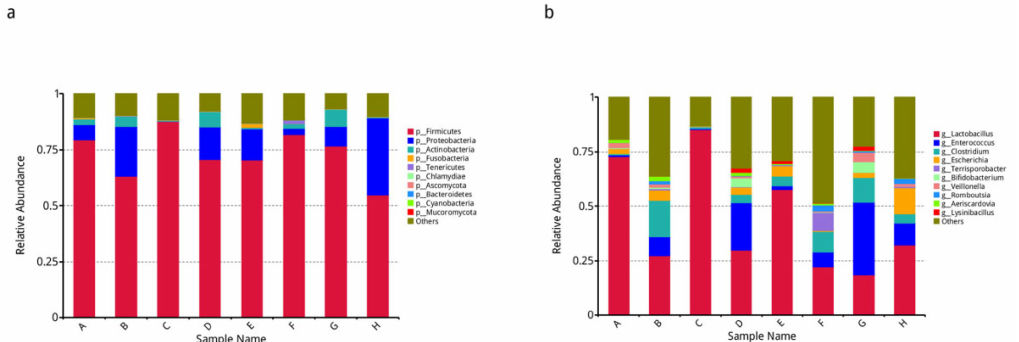
Figure 7. The relative abundance of species was presented at the phylum and genus levels. ( a ) Histogram of relative abundance was shown at the gate level. ( b ) Histogram of relative abundance was presented at the genus level. The horizontal axis represents the sample name. The vertical axis represents the relative proportion of species annotated to a certain type. The legend on the right is the species category corresponding to each colour block.